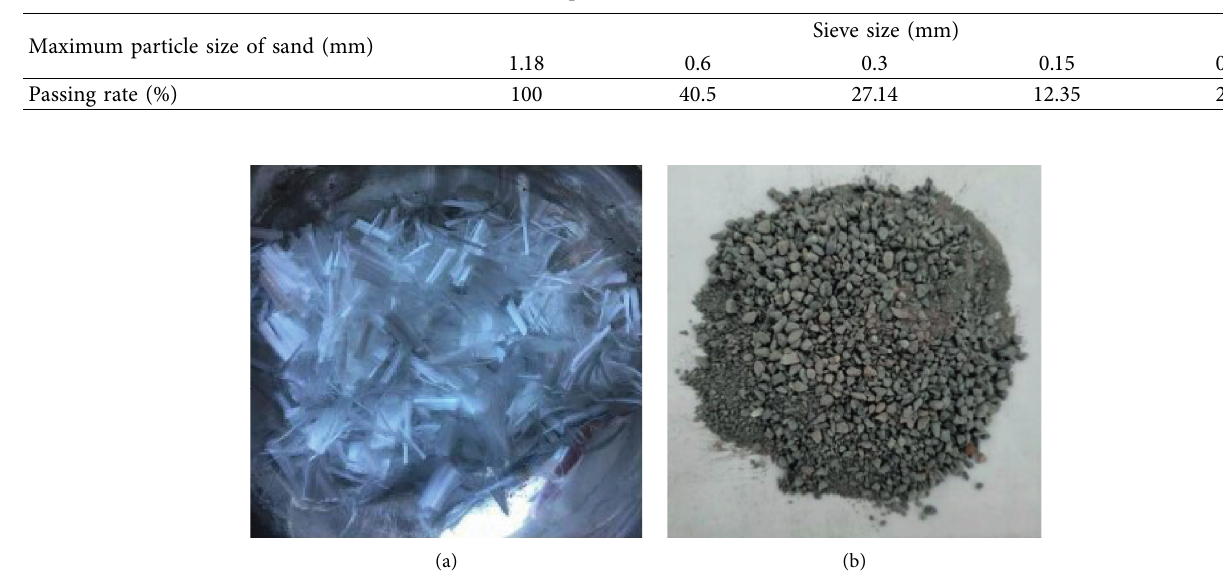
Table 2: Sieve pass rate of manufactured sand.